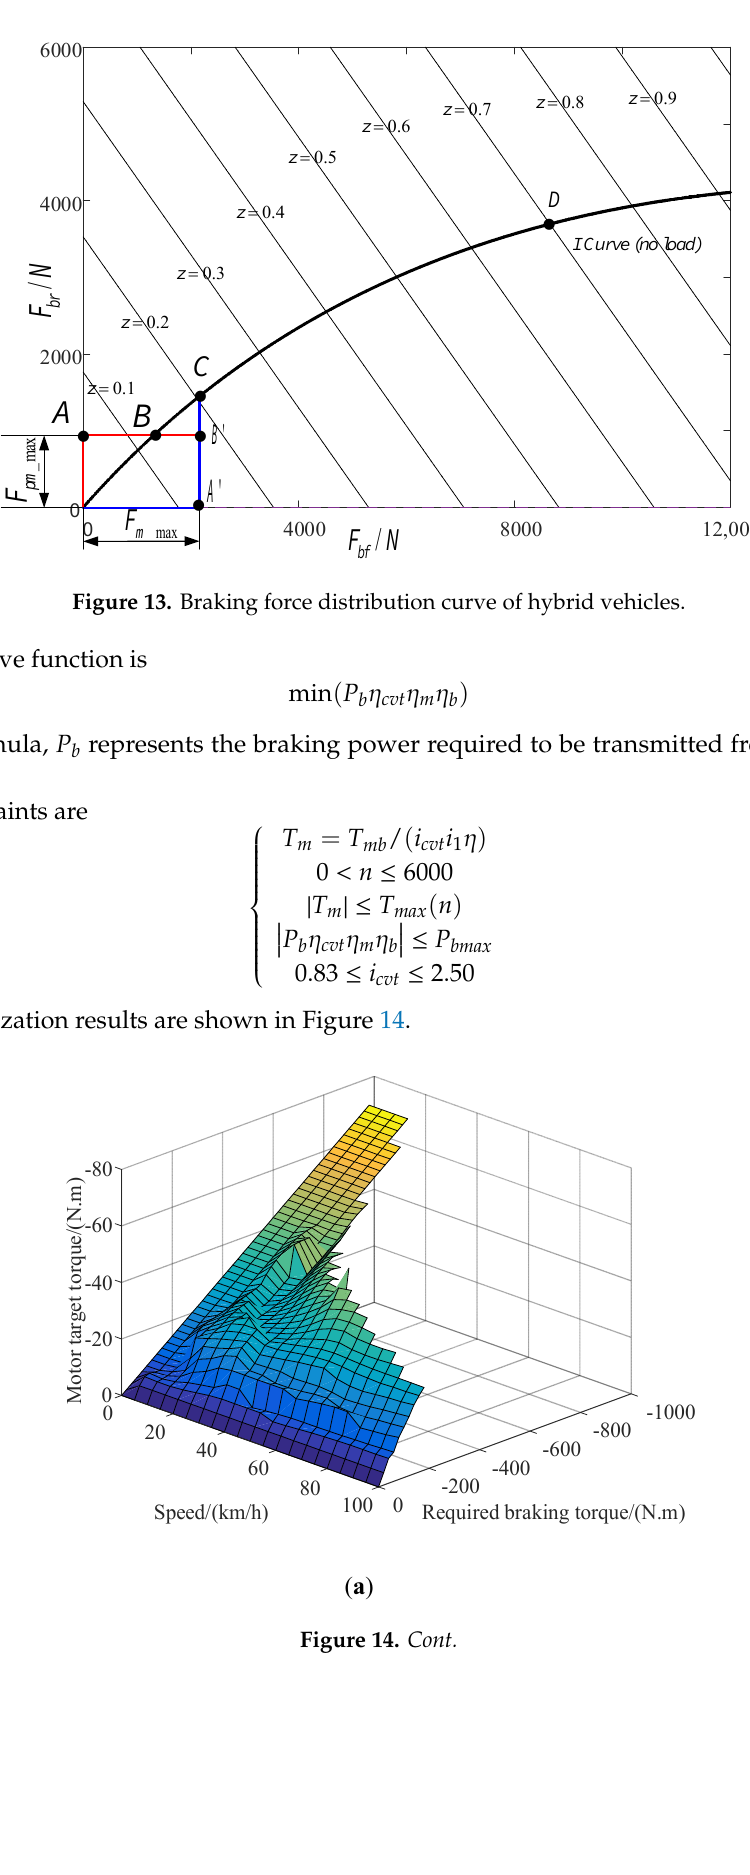
( d ) Figure 12. Optimization results in oil ‐ electro ‐ hydraulic hybrid drive mode: ( a ) hydraulic pump/motor target torque; ( b ) engine target torque; ( c ) motor target torque; ( d ) CVT target speed ratio. 4.2. Energy Management under Braking Conditions For a hybrid electric vehicle with a regenerative braking system, regarding the distribution of the braking force, it is necessary to solve the problems of not only the distribution of the braking force